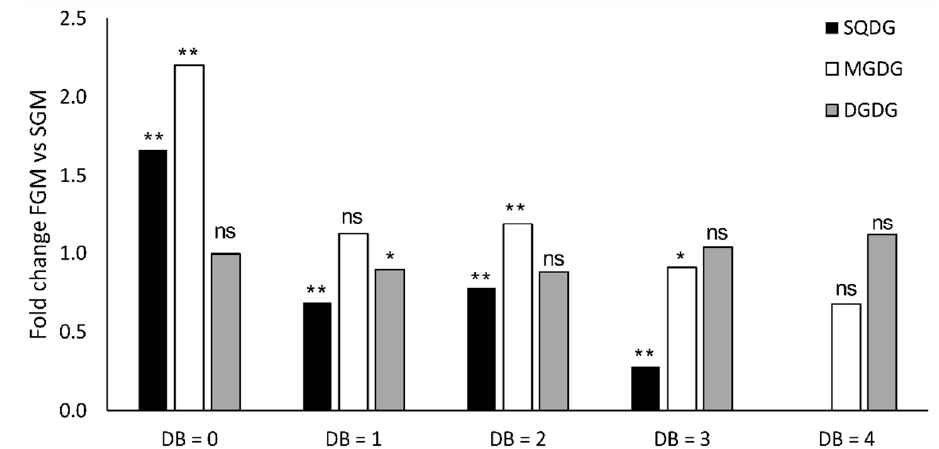
Figure 3. Comparison of the lipid unsaturation levels in Synechocystis sp. PCC 6803 wild-type strain lipidomes obtained from cells cultivated in fast- (FGM) or in slow-growth mode (SGM). For each lipid class, the indicated fold-changes were calculated based on the sum of peak areas of lipid species with particular level of unsaturation in FGM versus those in SGM. Data were normalized by the fold change of the total lipid content of each lipid class. DB, double bonds. * p < 0.05; ** p < 0.01; ns: not statistically significant difference.